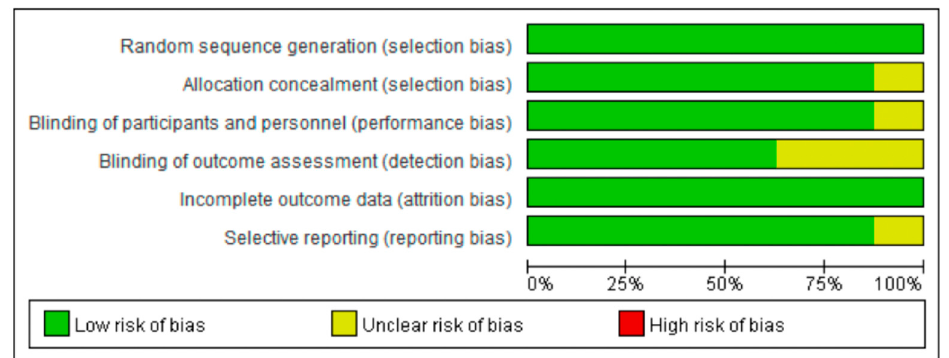
Figure 1. Risk of bias graph, with each risk of bias item reported as a percentage across all included